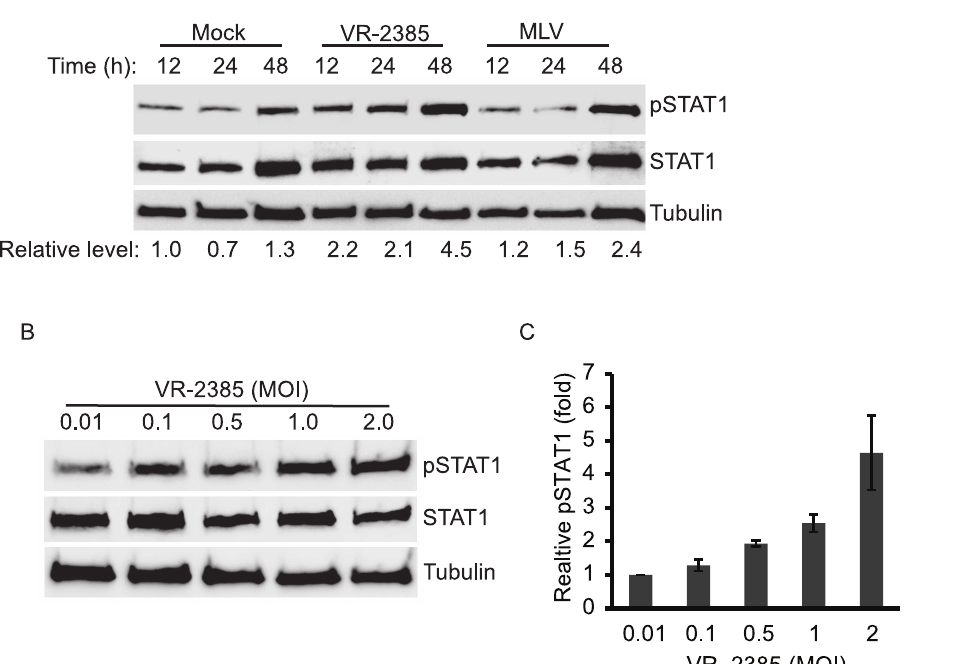
Figure 2. Kinetics and dose-dependent effect of PRRSV-induced elevation of pSTAT1-S727 (pSTAT1). A. Kinetics of pSTAT1-S727 in VR- 2385-infected cells. MARC-145 cells were infected with VR-2385 and MLV. The cells were harvested at 12, 24 and 48 hpi for Western blotting. Relative levels of pSTAT1 in comparison to the mock-infected cells of 12 hpi time point are shown as folds below the images. B. The pSTAT1 level increases along with incremental addition of VR-2385 virus inoculum. The MARC-145 cells were infected with 0.01, 0.1, 0.5, 1.0 and 2.0 MOI and harvested at 24 hpi for Western blotting. C. Densitometry analysis of pSTAT1 showing relative levels of pSTAT1 in comparison with cells inoculated with 0.01 MOI as folds after normalization with tubulin. Error bars indicate standard errors among three repeated